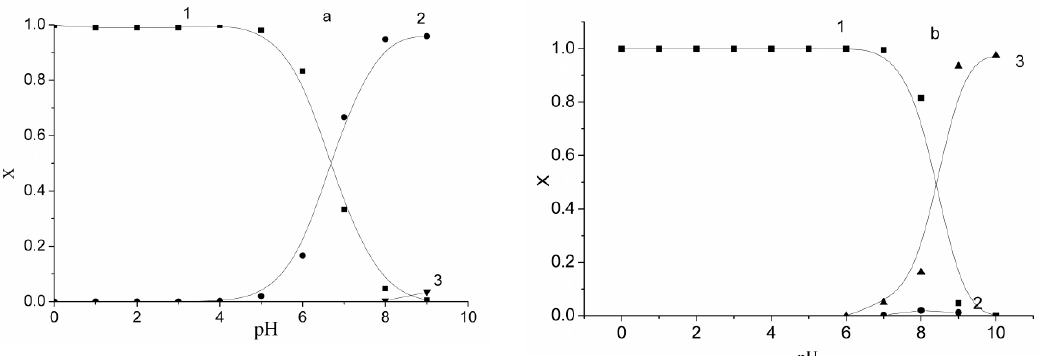
Figure A3. Elovich kinetics plots for Pb 2+ and Zn 2+ ion adsorption on titanium phosphate (the initial concentration of metal ions was 10 mmol·L −1 ).